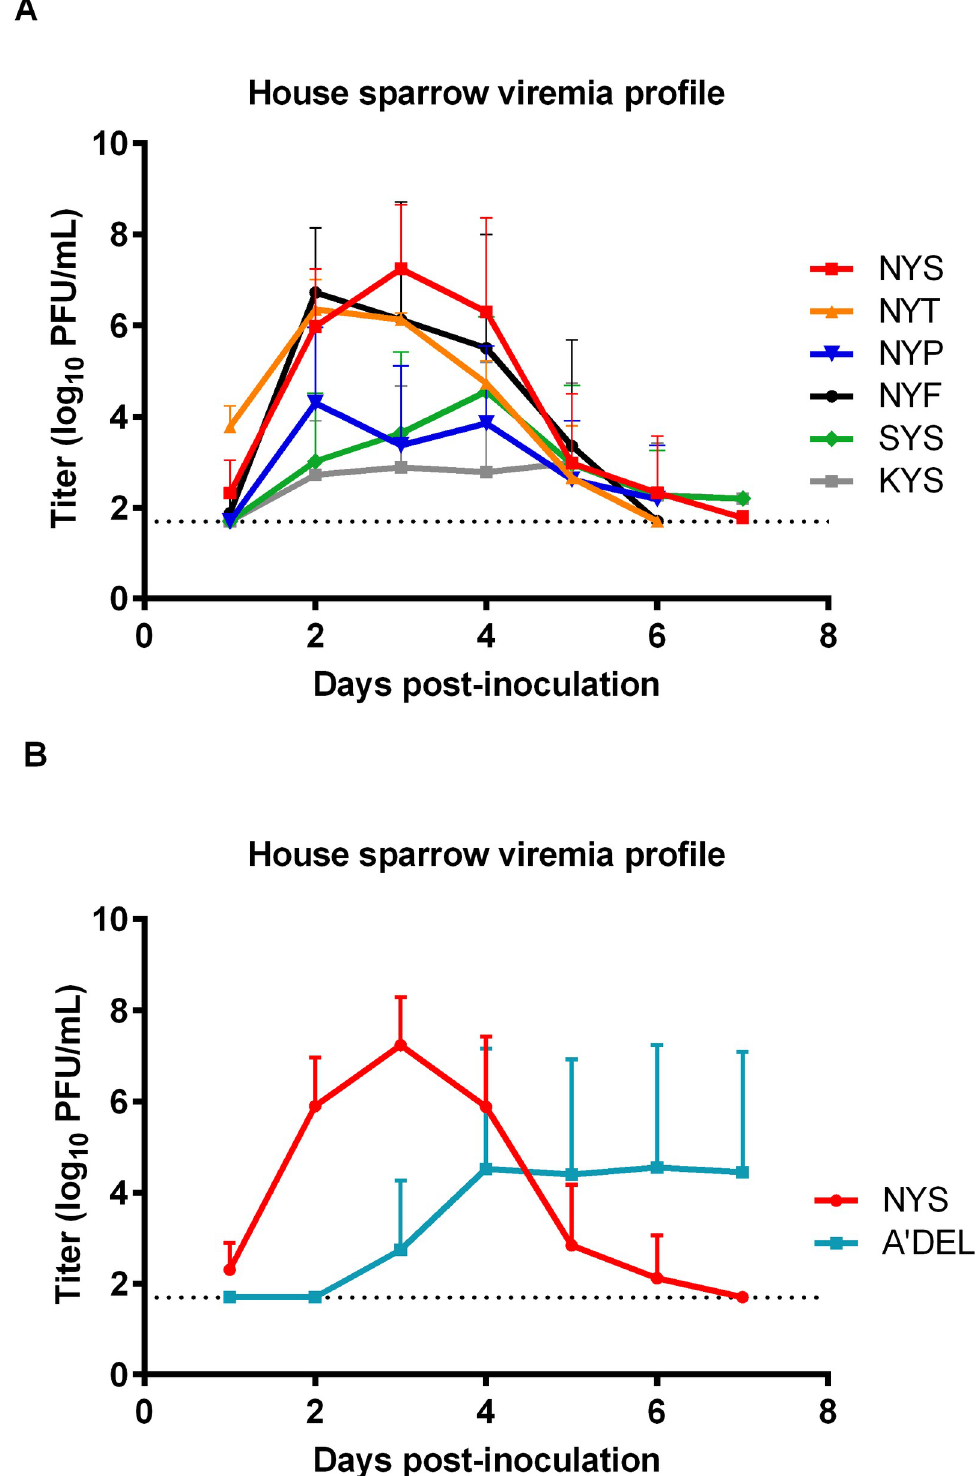
Fig 4. WNV glycosylation mutant virus growth and survivorship in house sparrows (HOSP). Viremia profiles of six HOSPs inoculated with 1,500 PFU of NYS and mutant WNVs. (A) Mean daily peak viremias (error bars denoted standard deviations from the mean) of HOSPs inoculated with NYS, NYT, NYP, NYF, SYS and KYS. (B) Mean daily